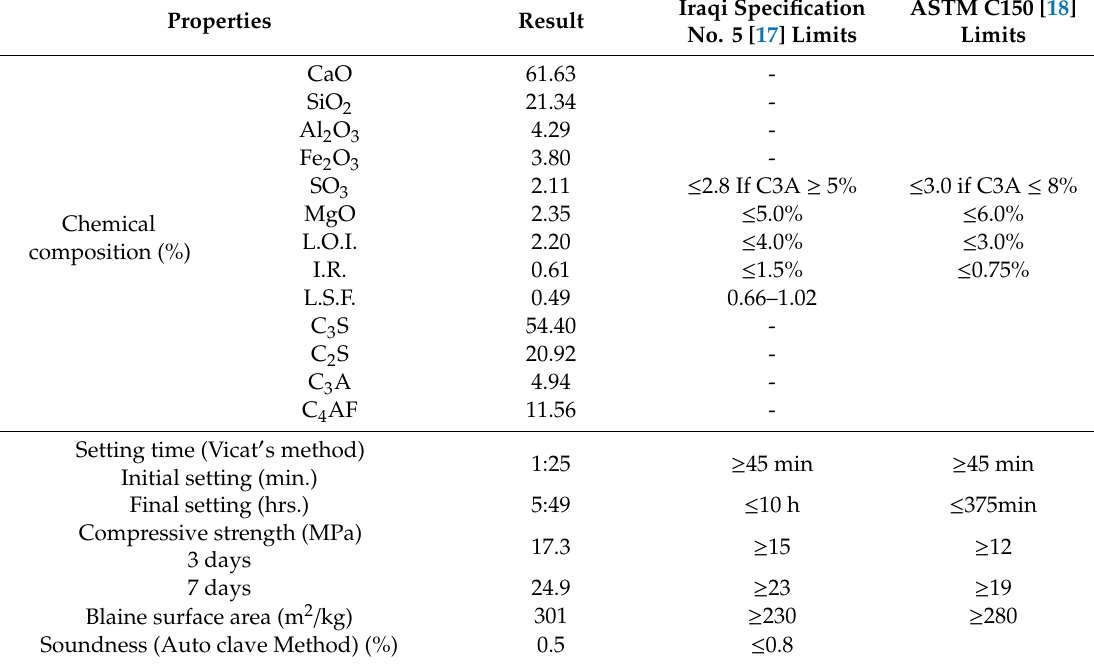
Cement properties.